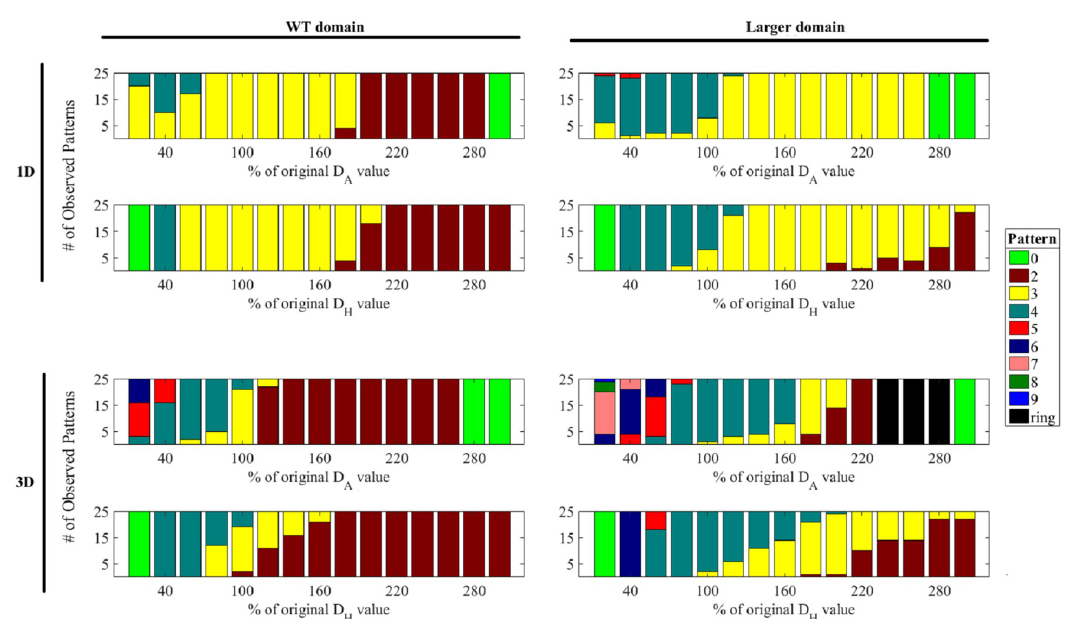
Fig 5. Increase in the diffusion rate leads to a decrease in spike number. In all domains, an increase in diffusion of either the activator ( D A , top two rows) or the inhibitor ( D H , bottom two rows) leads to a decrease in the number of spikes. The ring-like pattern had increased morphogen concentration along a great circle. The values of the diffusion parameters were varied from 20% to 300% of their original values from Table 1.